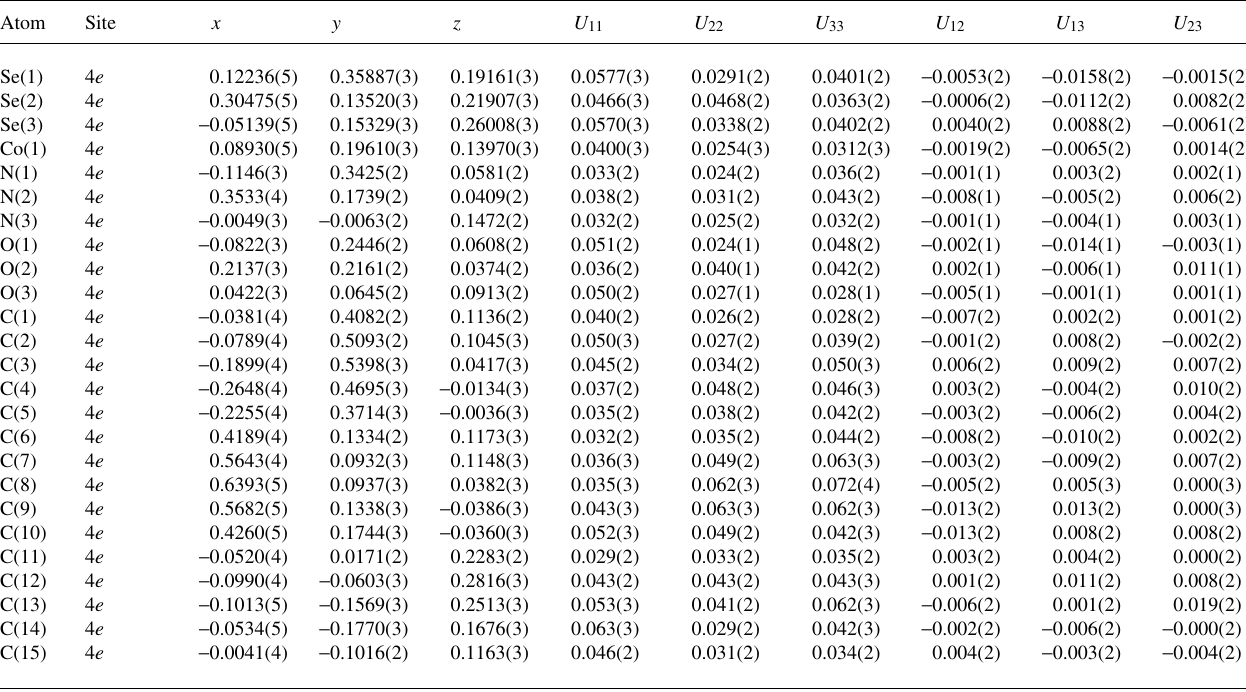
Table 3. Atomic coordinates and displacement parameters (in Å 2 ) .